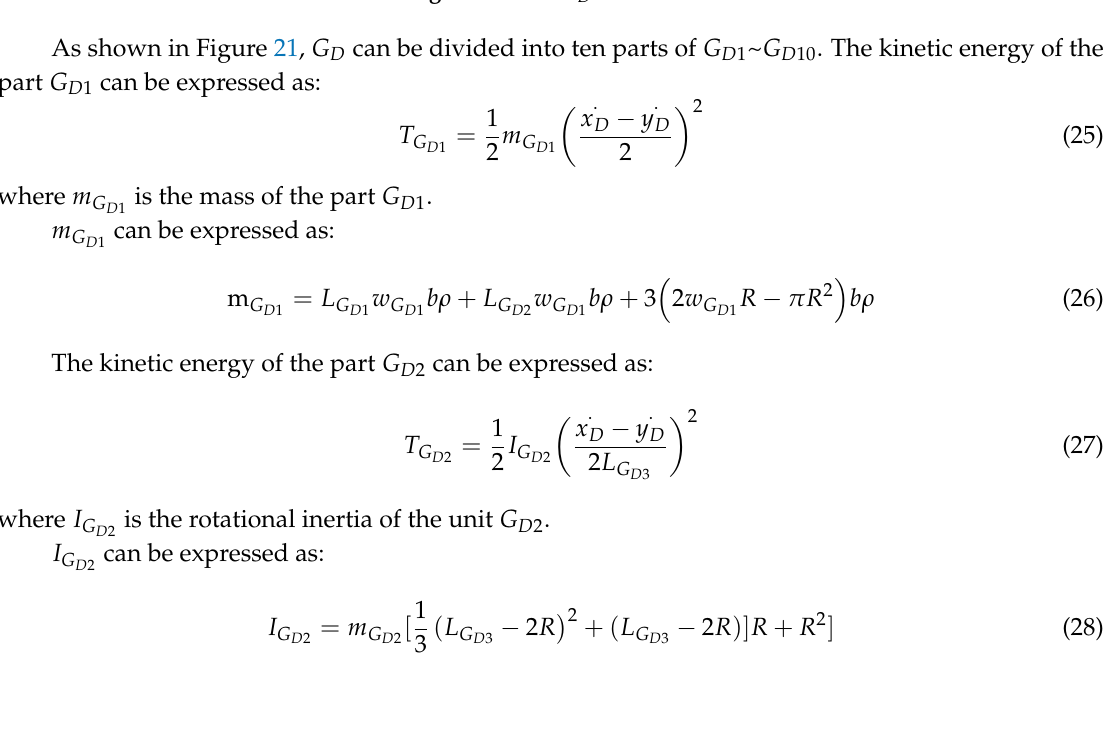
Figure 20. Unit 𝐹 (cid:3005) structure. Figure 20. Unit F D